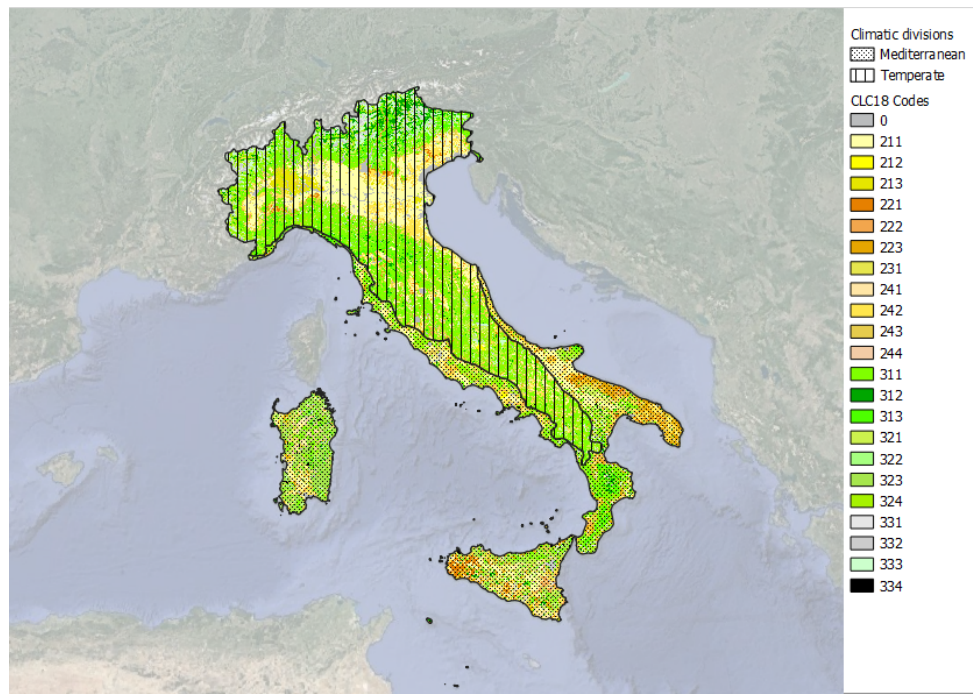
Figure 1. The distribution of the CORINE 2018 land cover classes in Italy. All non-burnable classes have been merged in the type 0. The two climatic subdivisions of Italy [30,31], the Mediterranean (dotted part) and the Temperate (hashed part) one, are also represented.